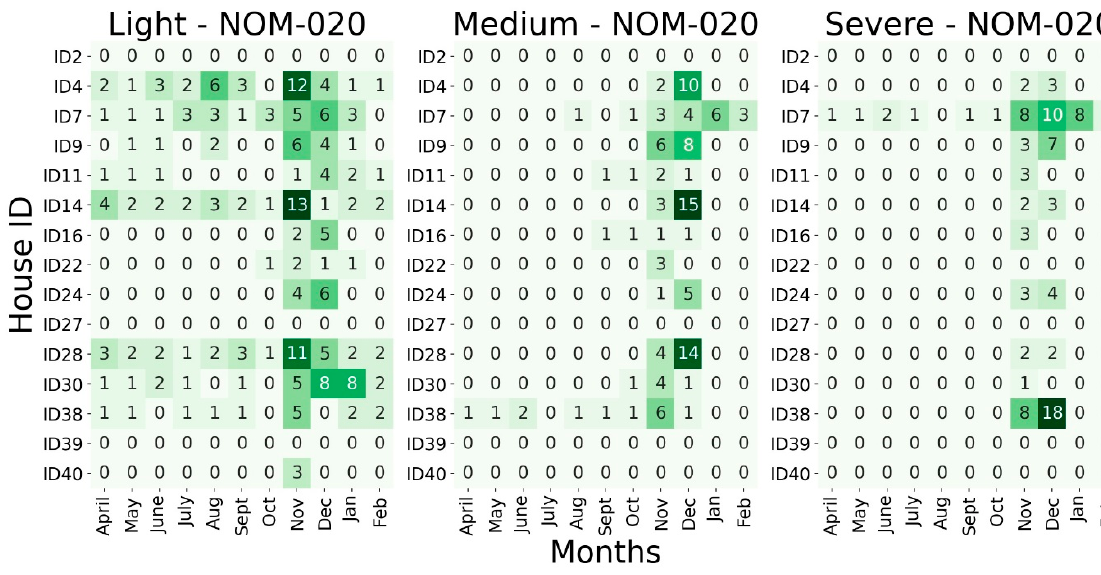
Figure A10. Results of the underheating criteria 2 applied to the models simulated under the NOM- 020 standard. The X axis shows the months, and Y axis shows the house ID. The intersection of both shows the number of underheated light (left), medium (middle), and severe (right) days in that month.